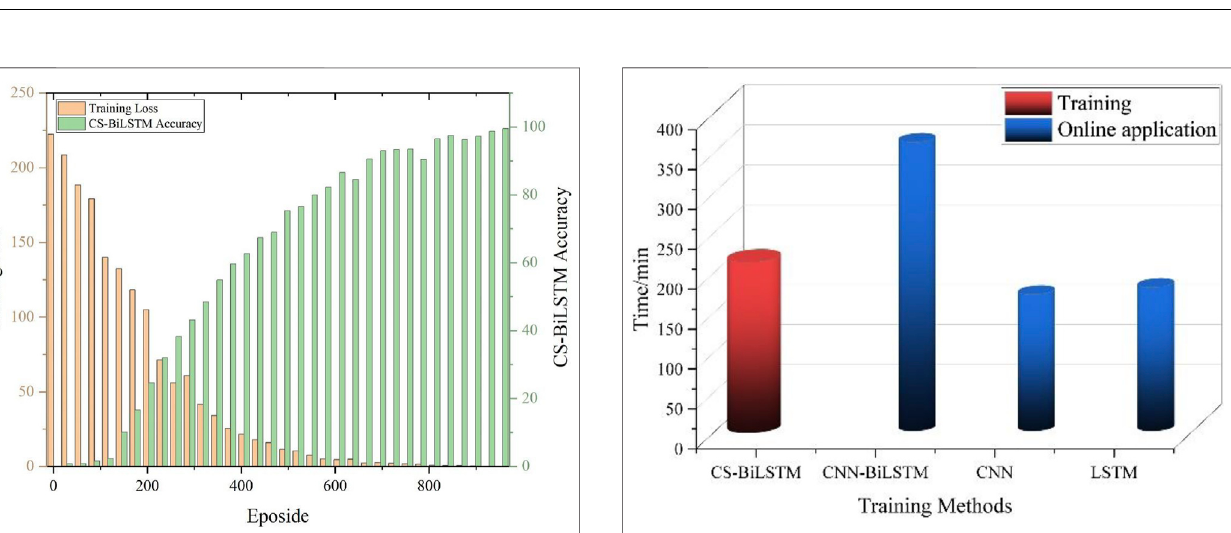
FIGURE 7 | Simulation waveform of the original signal and reconstructed signal.